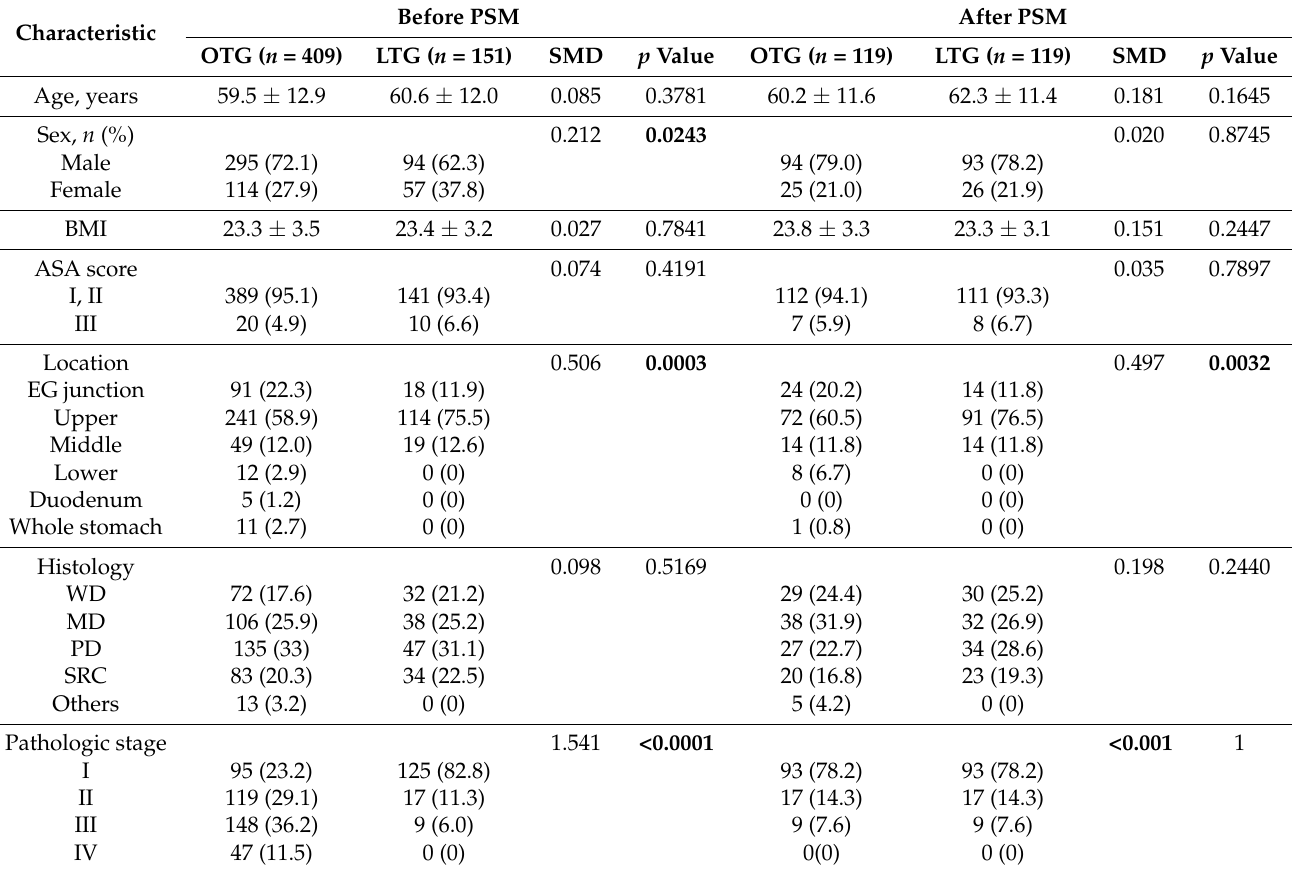
Table 1. Clinicopathological characteristics of